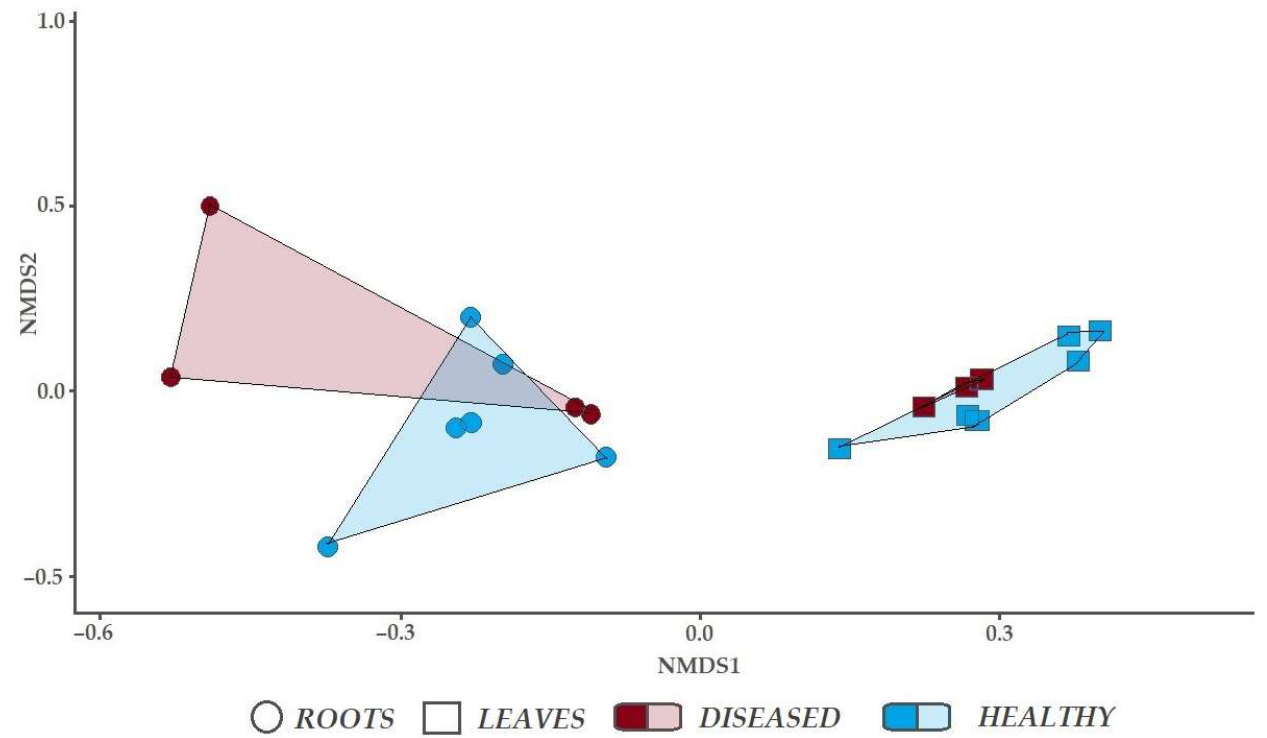
Figure 4. Non-metric multidimensional scaling for fungal communities associated with leaves and roots of healthy-looking and diseased Ulmus glabra .